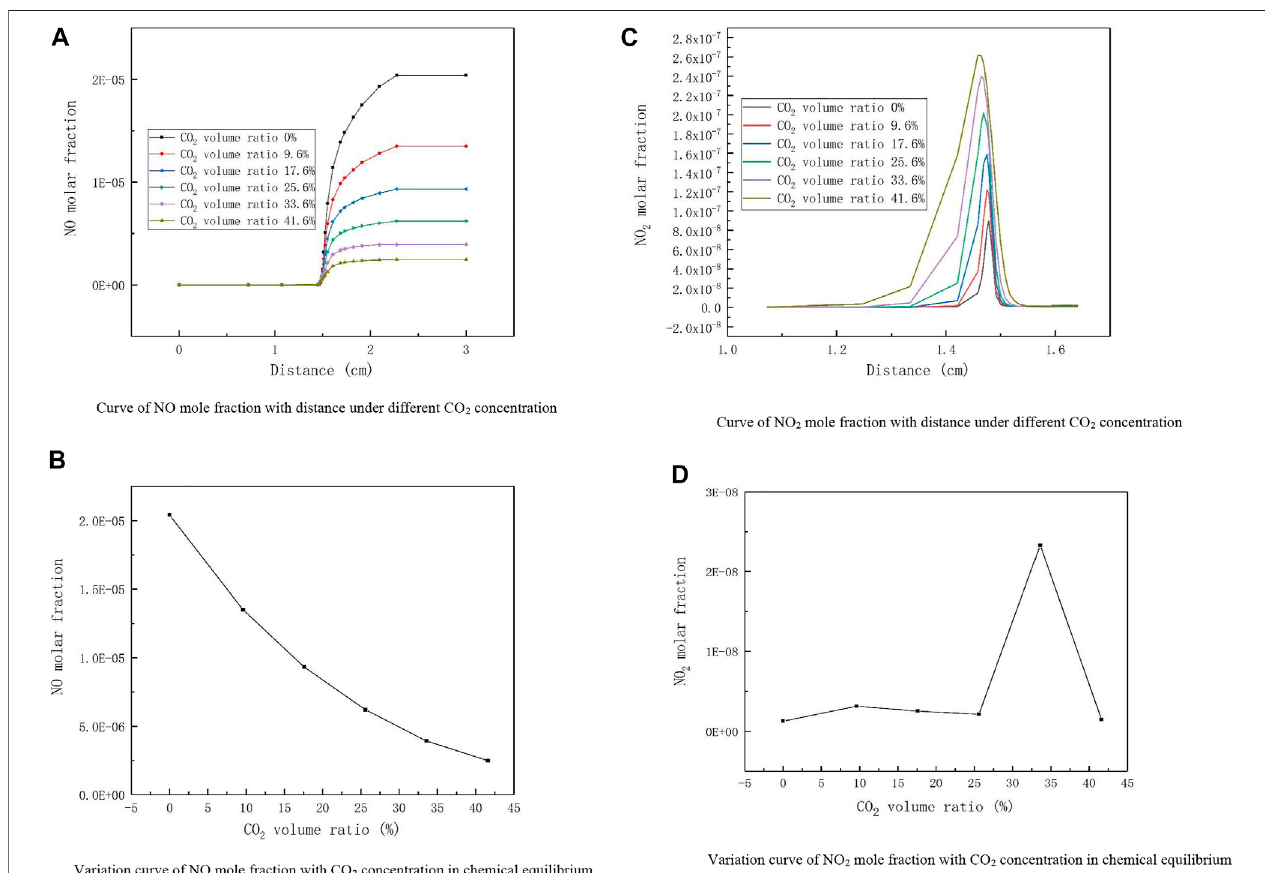
FIGURE 3 | Distribution curve of nitrogen oxides under different CO 2 concentrations. (A) Curve of NO mole fraction with distance under different CO2 concentration. (B) Variation curve ofNOmole fraction withCO2concentrationinchemicalequilibrium. (C) Curve ofNO2mole fraction withdistanceunderdifferentCO2 concentration. (D) Variation curve of NO2 mole fraction with CO2 concentration in chemical equilibrium.